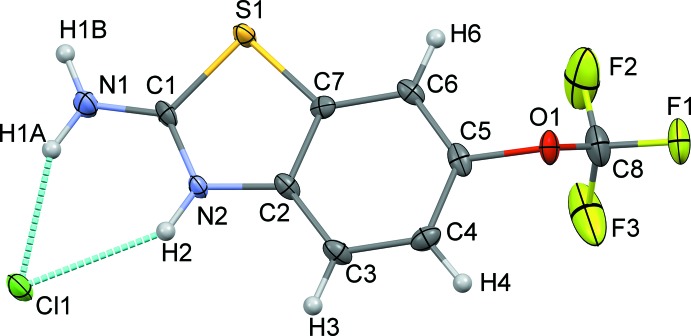

ORTEP view of riluzolium chloride drawn with 50% ellipsoidal probability. The dotted lines depict inter­molecular inter­actions in the asymmetric unit.